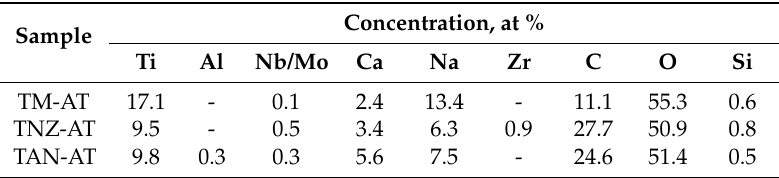
Figure 6. XPS (X-ray photoelectron spectroscopy) survey spectra of plasma electrolytic oxidation (PEO)-treated Ti-6Al-7Nb (TAN), Ti-15Mo (TM) and Ti-13Nb-13Zr (TNZ) alloys. Table 3. Surface composition of alkali-treated titanium alloys.